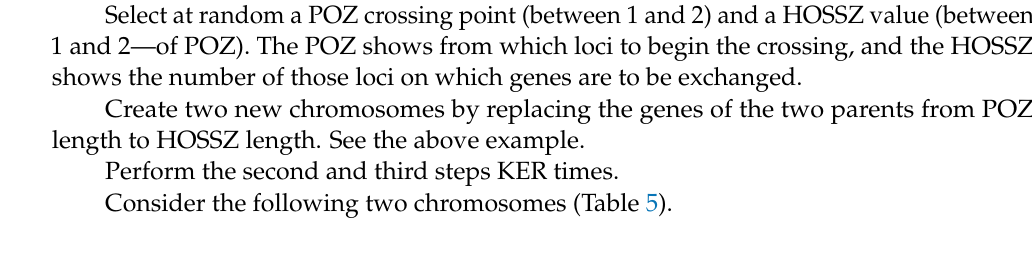
Table 5. Chromosome of parent entities.